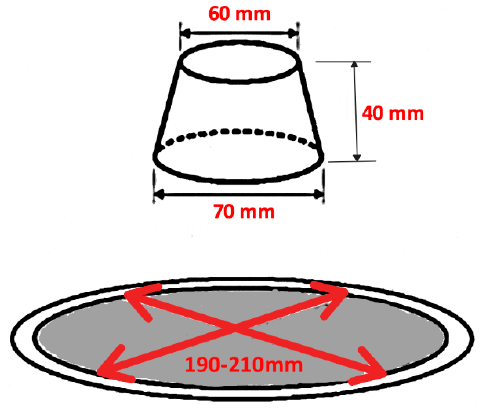
Figure 5. Principle of mortar spread measurement.